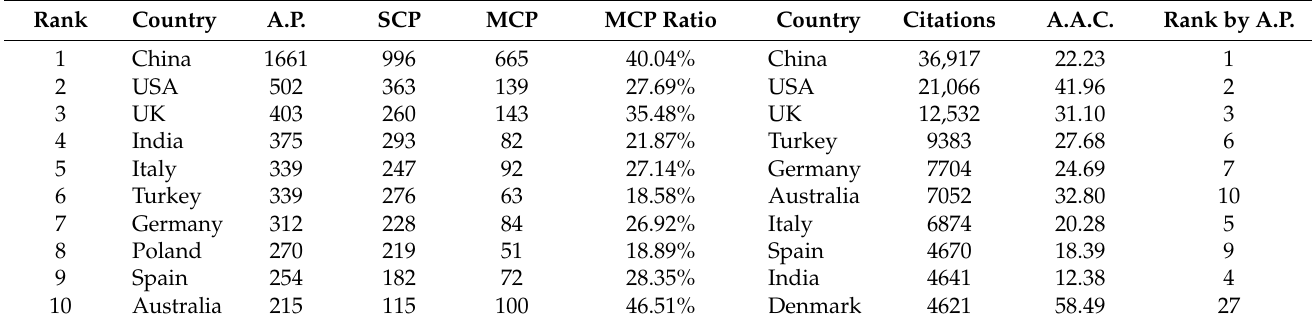
Table 8. Top 10 countries by scientific production and by number of citations.